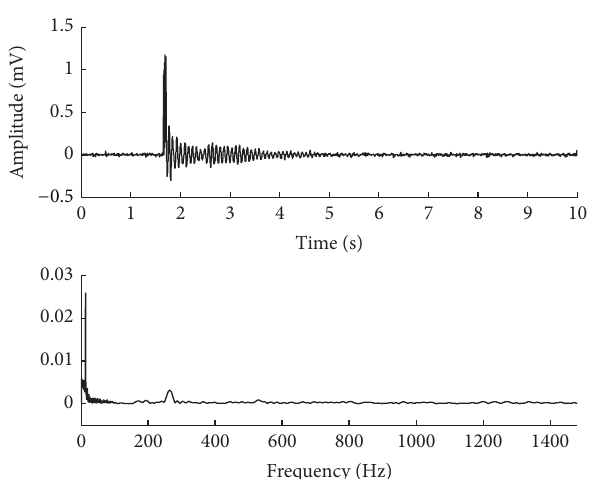
Figure 10: TEM signal processed by EEMD.